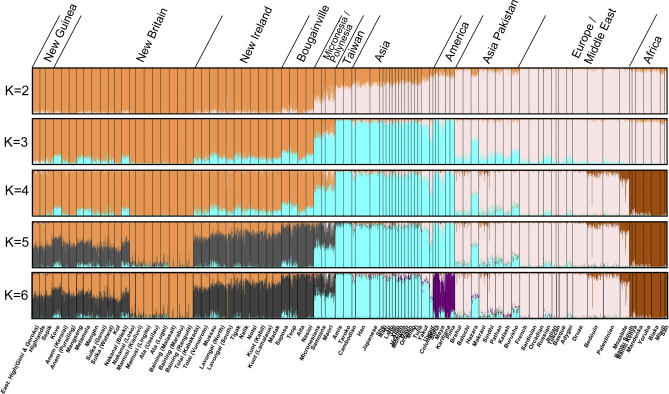
Global Population StructureSTRUCTURE analysis of the Pacific and HGDP-CEPH sets combined, for 687 microsatellites and 203 indels over 91 populations encompassing 1,893 samples (20,000/10,000 burnin/MCMC). Each vertical line represents an individual. The colors represent the proportion of inferred ancestry from K ancestral populations.